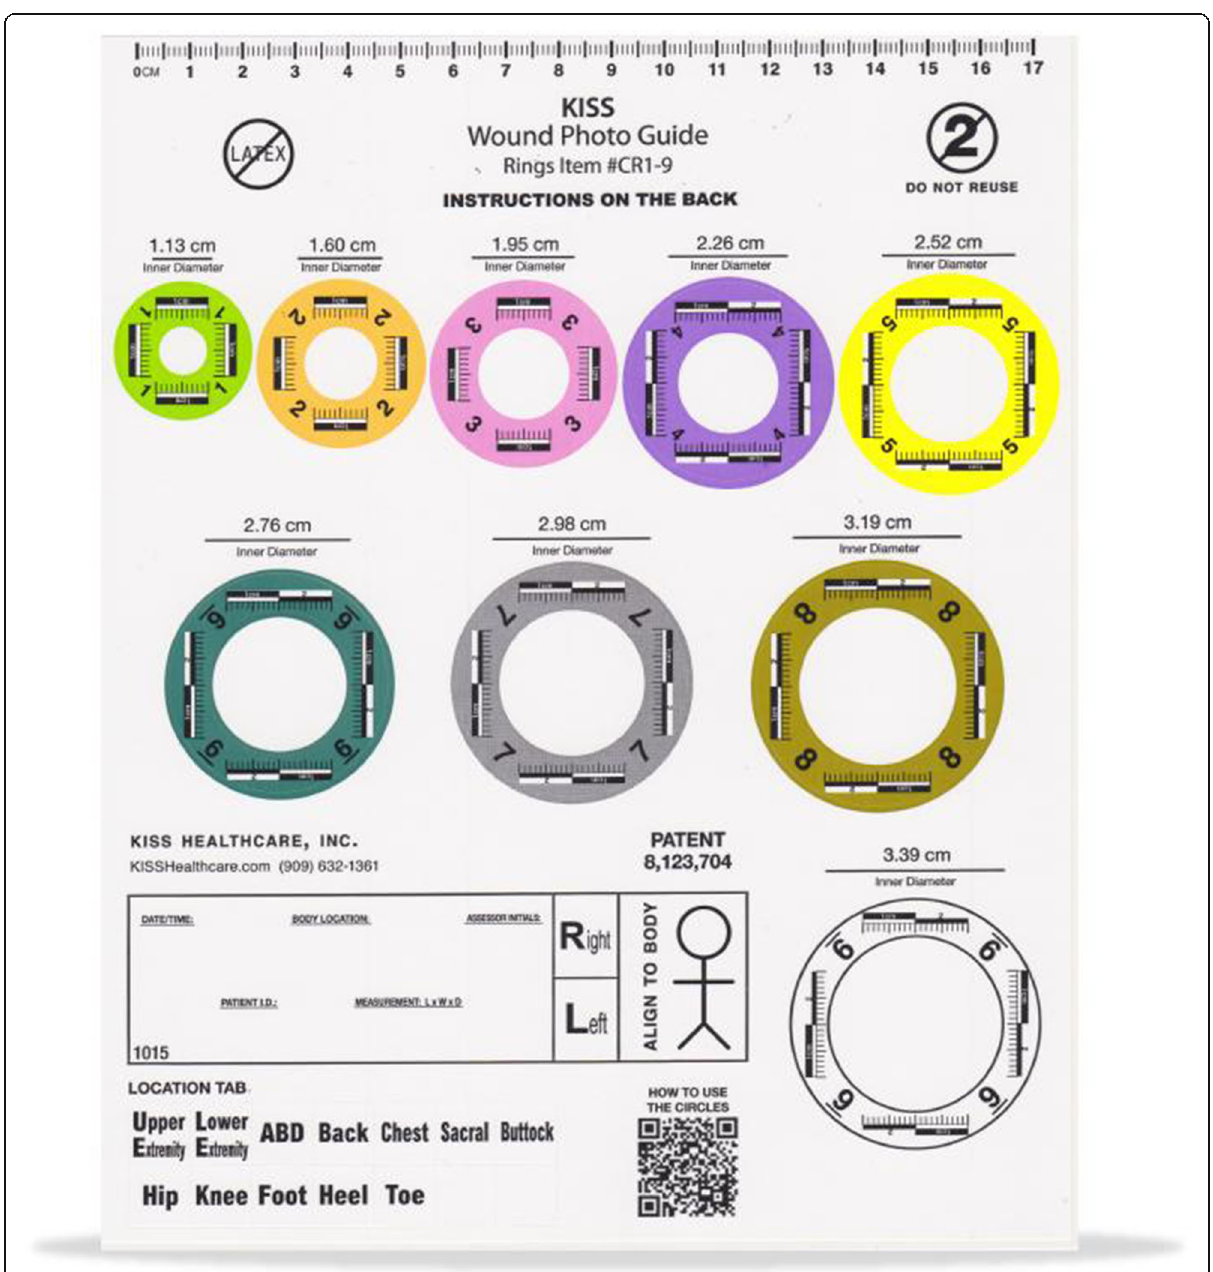
Fig. 3 The KISS wound photo guides — circle scales for knee, foot, heel and toe. Reprinted with permission from TJ Richards, CEO, KISS Healthcare,